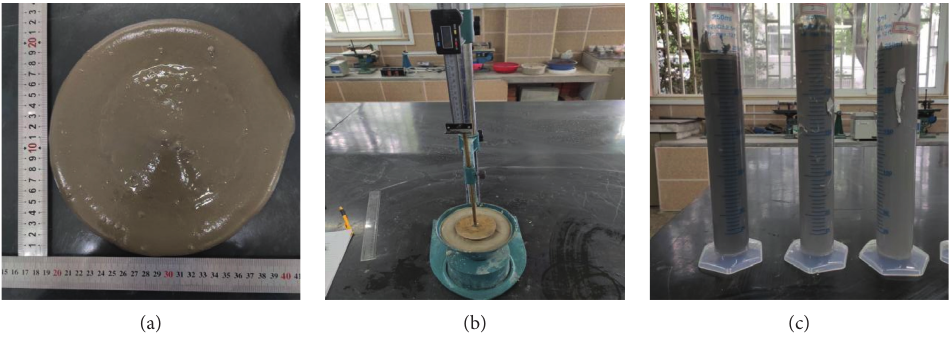
Figure 2: Tests on fresh grouting materials: (a) fluidity; (b) consistency; and (c) bleeding ratio.